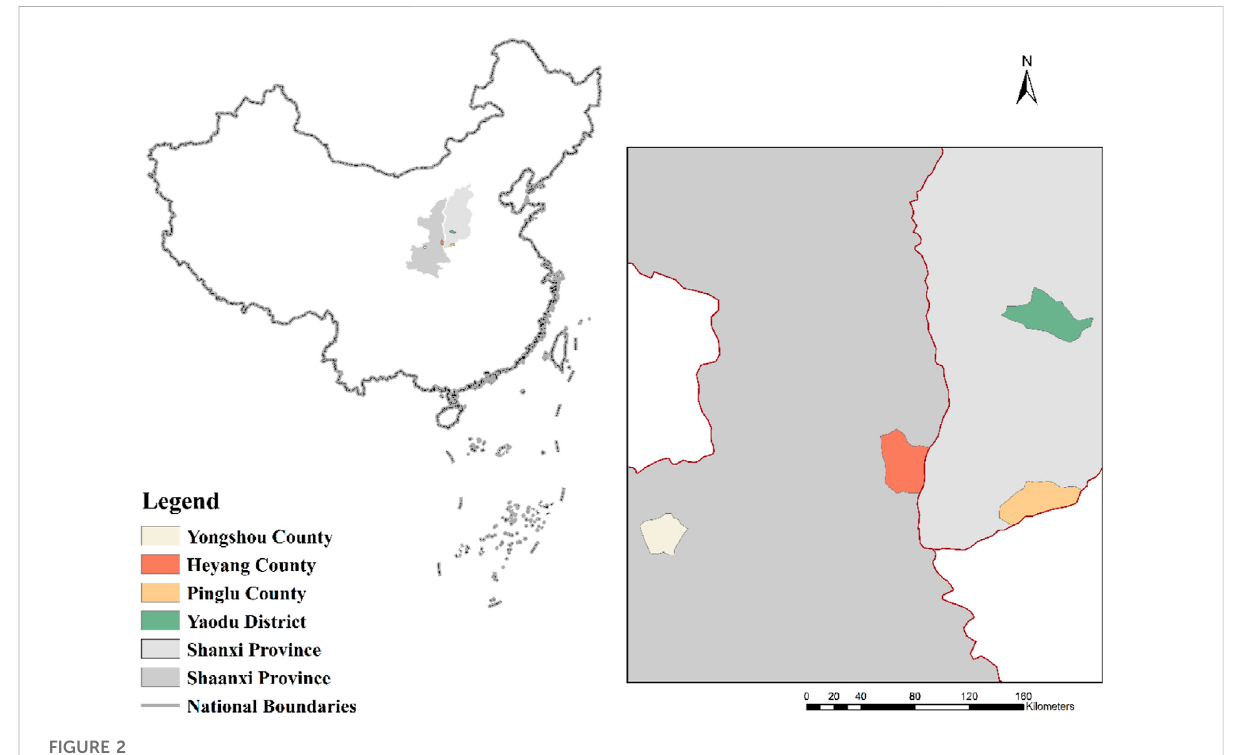
FIGURE 2 Survey site distribution map.